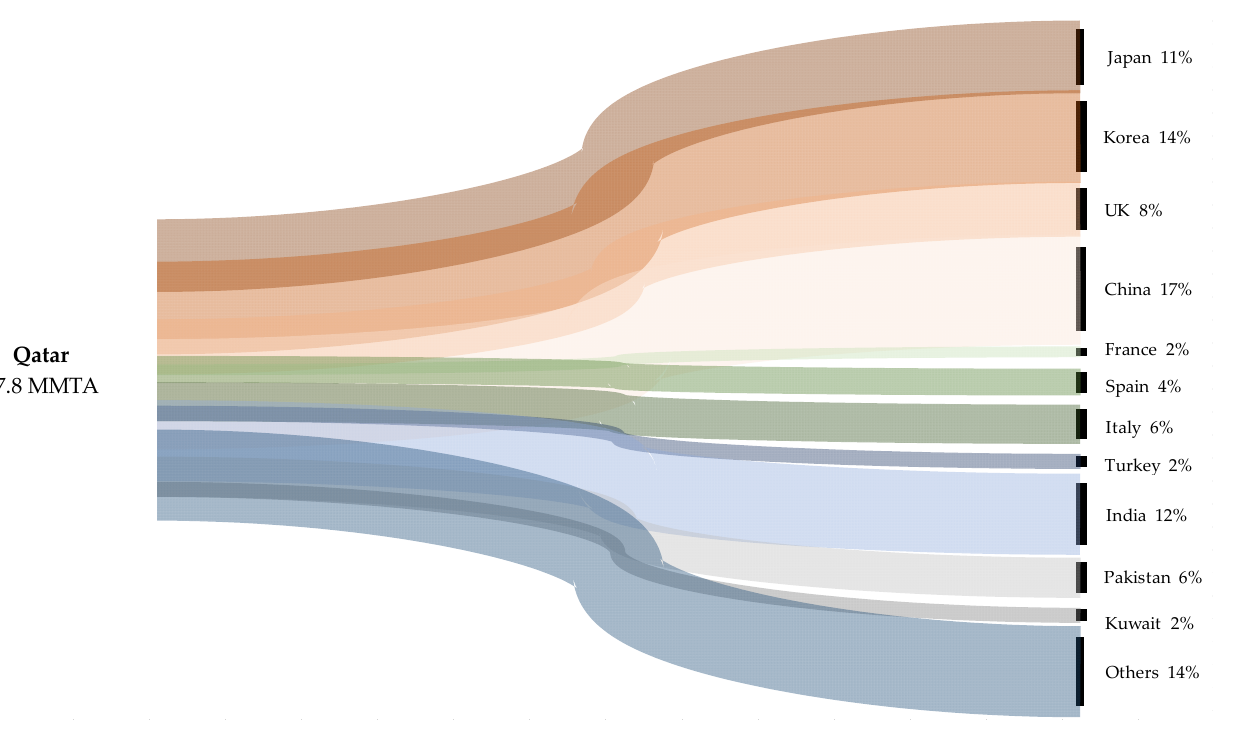
Figure 2. Qatar LNG’s current production and the demand of the main 11 destinations. Each LNG fleet’s capacity used in the research is displayed in Table 1: Table 1. Q-Flex, Q-Max, and Conventional carriers’ loading